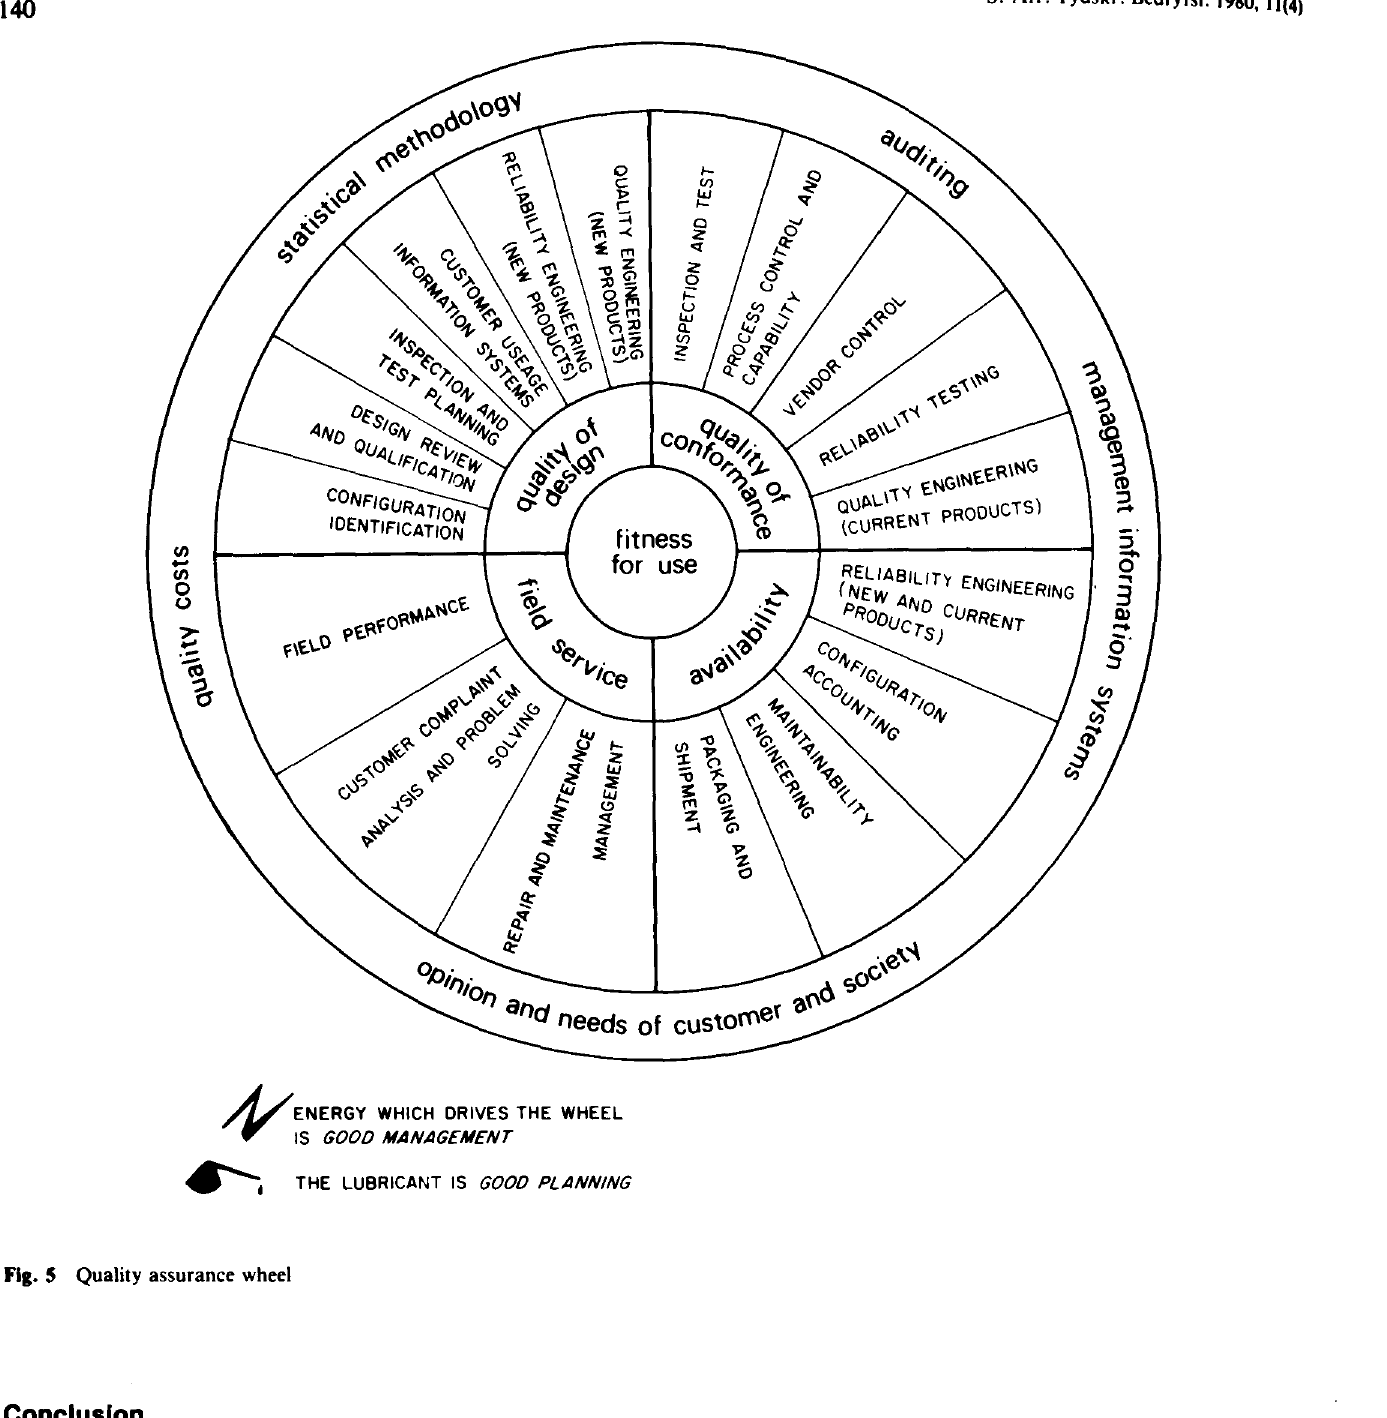
Fig. 5 Quality assurance